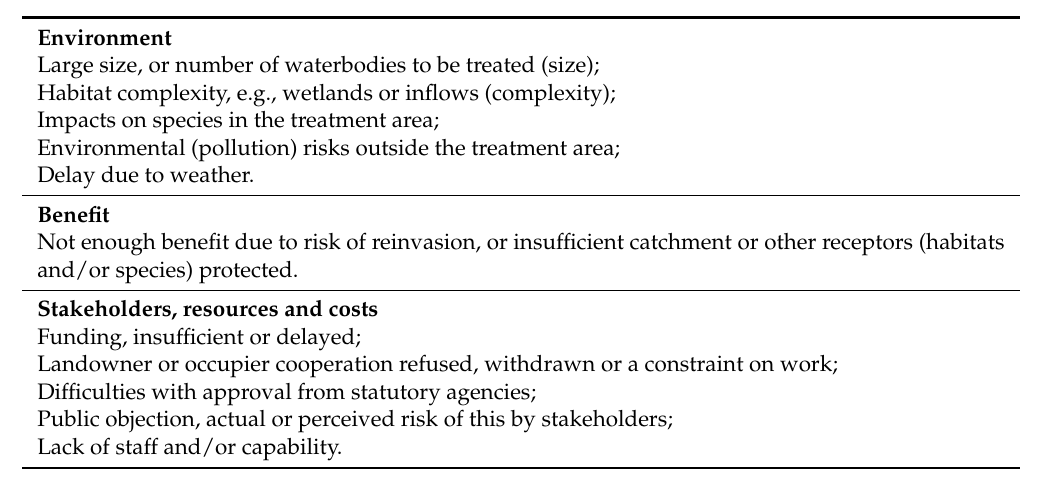
Table 4. The categories of constraints on biocide treatment projects.